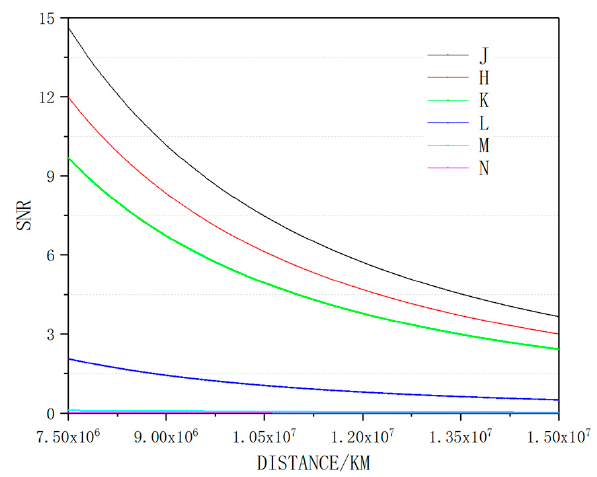
Figure 4. SNR at different detection distances.